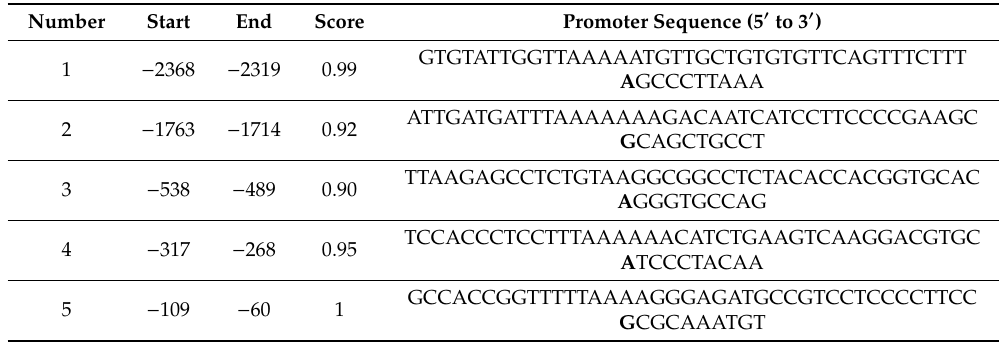
Table 1. The prediction results of AMH gene core transcriptional promoter region in geese.